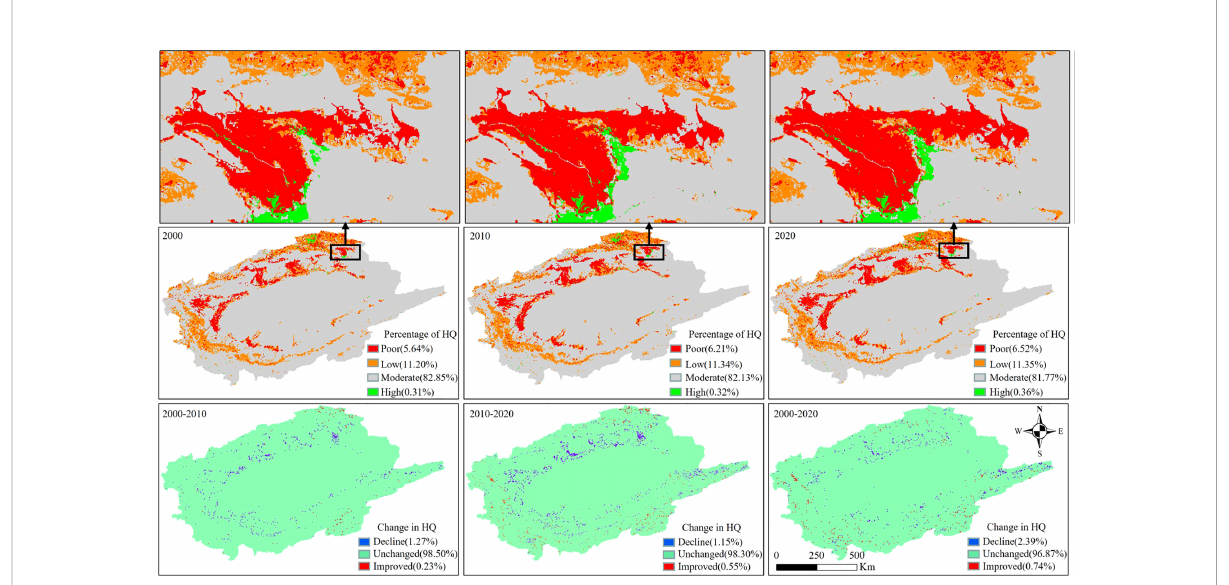
FIGURE 5 Spatial distribution and changes of habitat quality (HQ) level, and percentage share from 2000 to